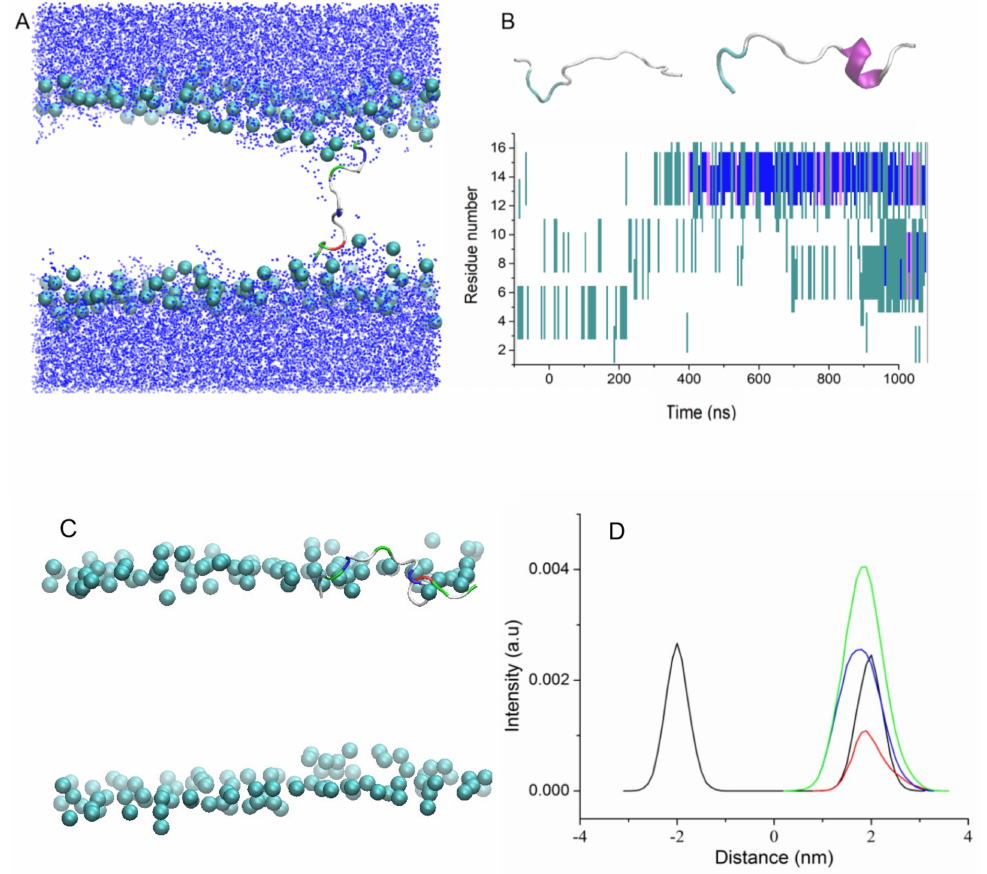
Figure 4. Snapshots of the systems for the simulations Tr7 ( A ) and Tr9 ( C ). Peptides are shown in the cartoon and are colored according to residue types. ( B ) Time evolution of the secondary structure of peptide. White, cyan, blue, and purple colors correspond to a random coil, a turn, a π -helix, and an alpha-helix, respectively. Density profiles ( D ) along the bilayer normal are plotted for the phosphate group (black), peptides (green), hydrophilic residues (red), and hydrophobic residues (blue). In Figure 4A,C, lipids are hidden for